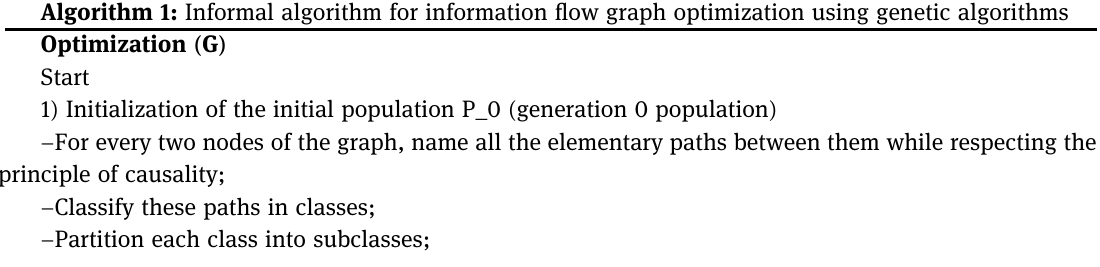
Figure 4: Real Example of a chromosome of 3